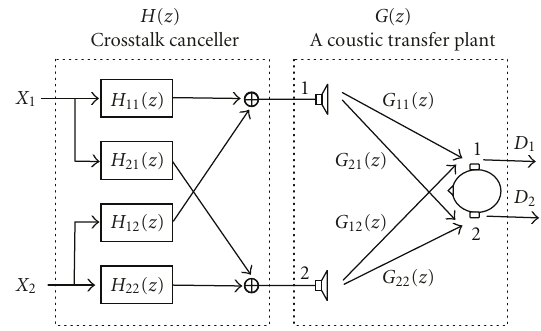
Figure 1: Block diagram of the direct crosstalk cancellation system for stereo